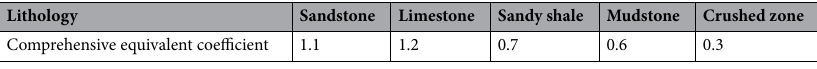
Table 1. Conversion factor for the thickness of